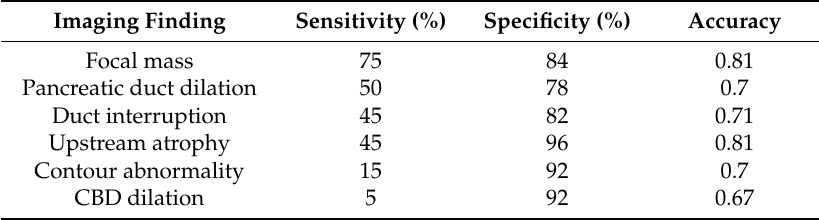
Table 5. Computed tomography (CT) features predicting the presence of pancreatic cancer